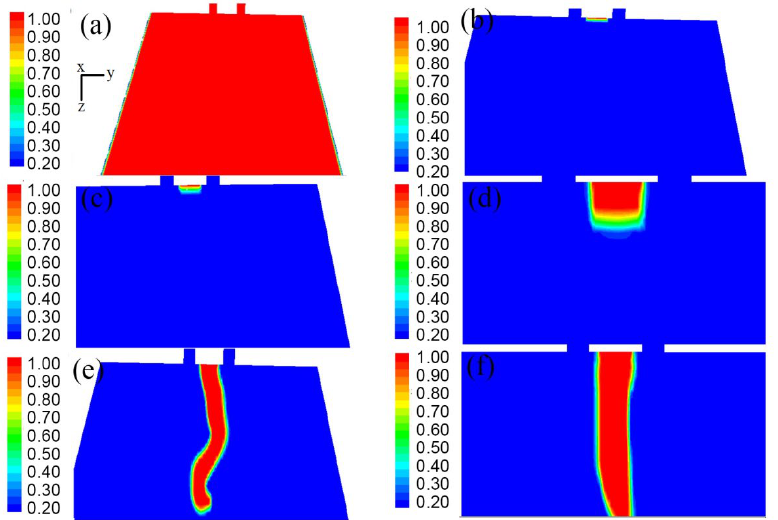
Figure 13. Movement trajectories of melt-blown fibers at different times, showing: ( a ) the y–z plane at time t = 1 × 10 − 7 s; ( b ) the y–z plane at time t = 1.6 × 10 − 6 s; ( c ) the y–z plane at time t = 2.9790 × 10 − 5 s; ( d ) the y–z plane at time t = 1.3379 × 10 − 4 s; ( e ) the y–z plane at time t = 6.0128 × 10 − 3 s; ( f ) the y–z plane at time t = 1.5430 × 10 − 2 s.